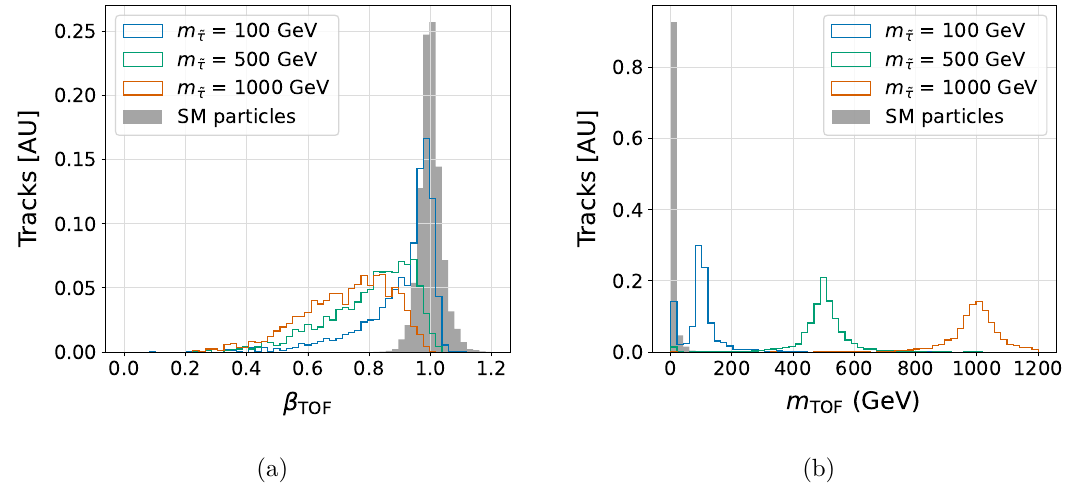
Figure 19. Measured β (a) and mass (b) for different stau masses. These distributions incorporate a realistic spread in collision time and z position, as well as the timing layer’s temporal resolution. SM particles with p 10 GeV from the signal samples are shown for T >